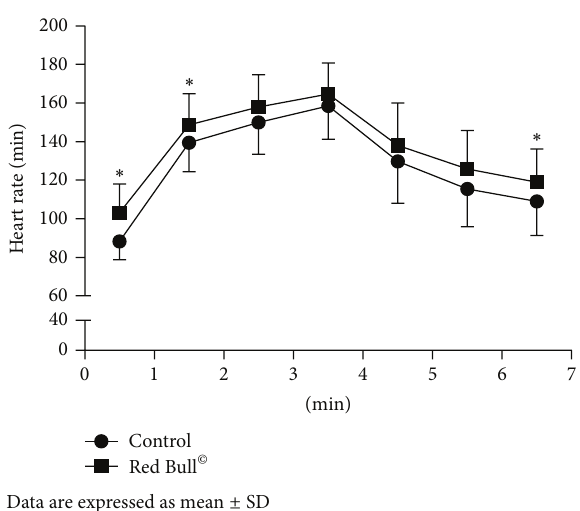
Figure 3: Change of respiration rate (RR) during 1 minute rest, 3 minute of Harvard Step Test and 3 minute rest after exercise before and after Red Bull © consumption.